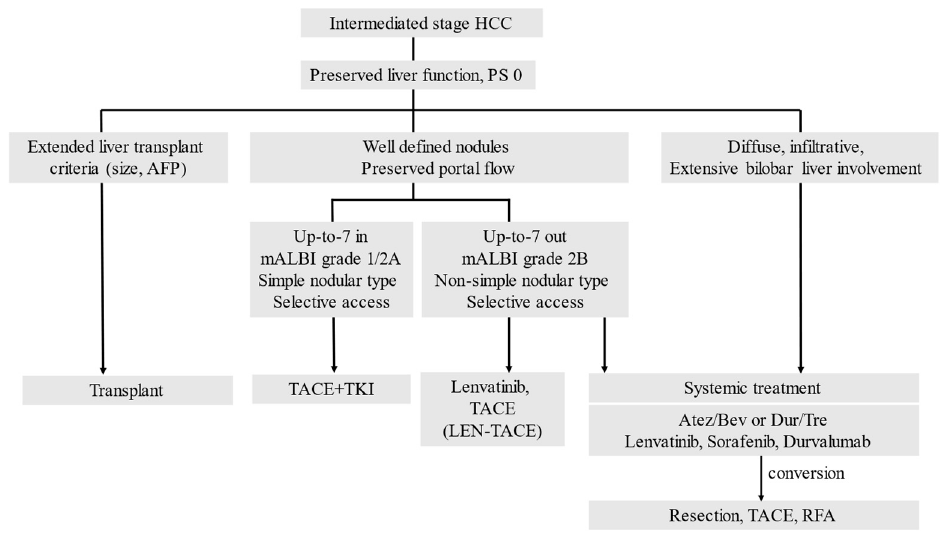
Figure 3. Treatment strategy for intermediate-stage HCC.